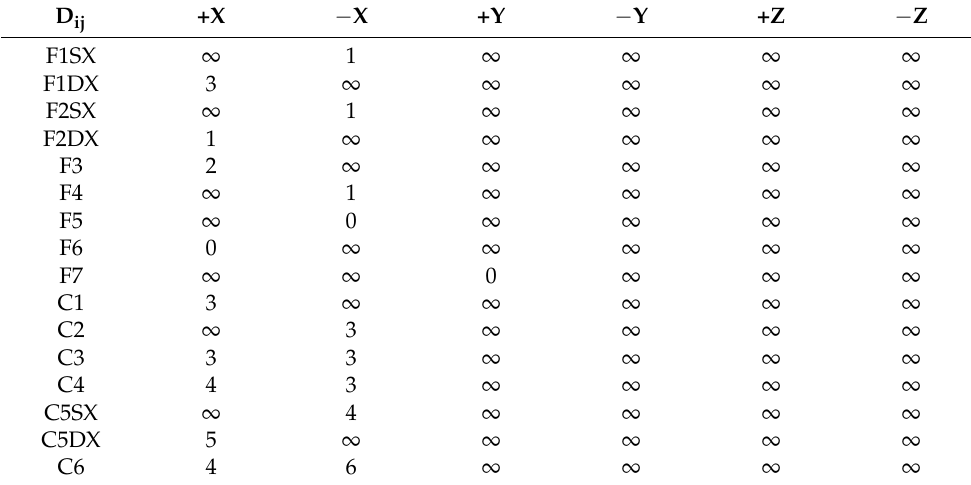
Table 3. Interference matrix.